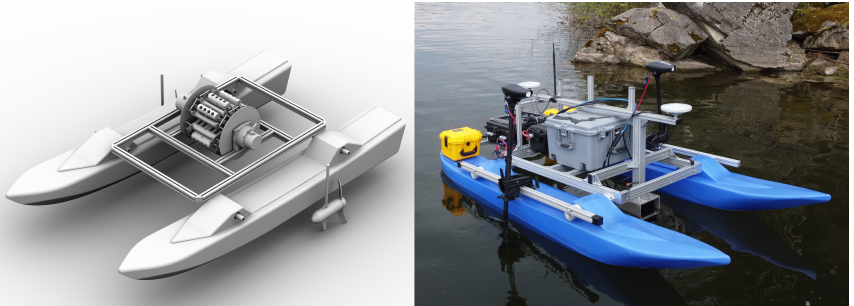
Figure 22. Construction model and ASV-prototype for the next level with a higher performance and streamlined design of the winch and sonar